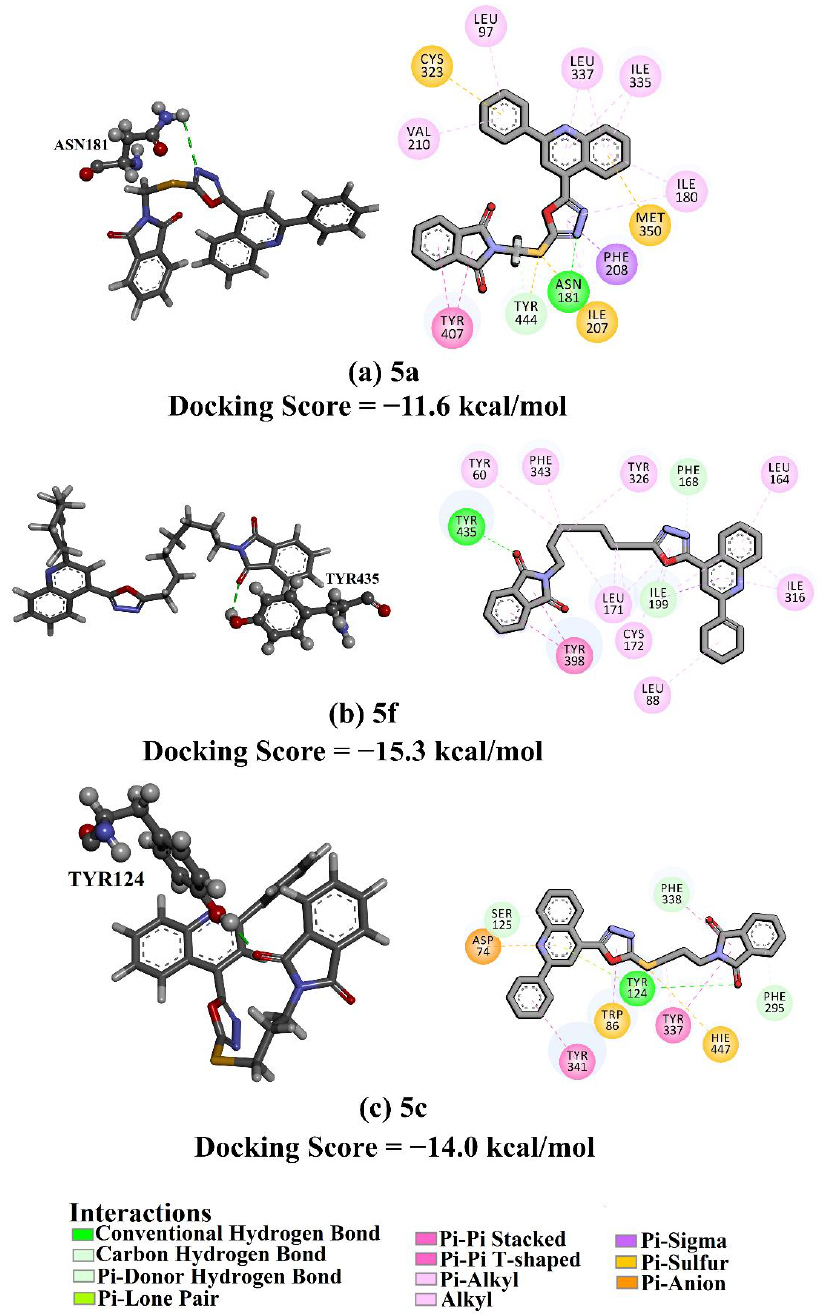
Figure 5. Predicted docking scores (in kcal/mol) and docking poses of ( a ) 5a with MAO-A, ( b ) 5f with MAO-B, and ( c ) 5c with AChE.